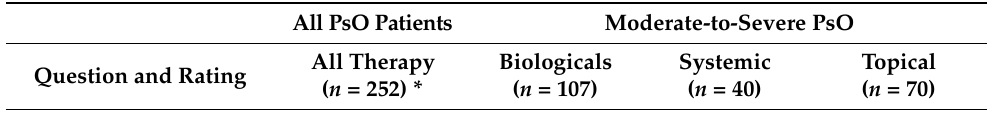
Table 3. Summary of results derived from survey questions related to the impact of psoriasis treatment on signs and symptoms, quality of life and